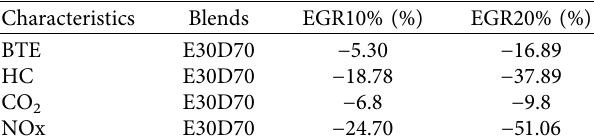
Figure 4: Variation in BTE with EGR (0%, 10%, and 20%) at 60% load. Table 7: Comparison of E30D70 vs. E10D90.